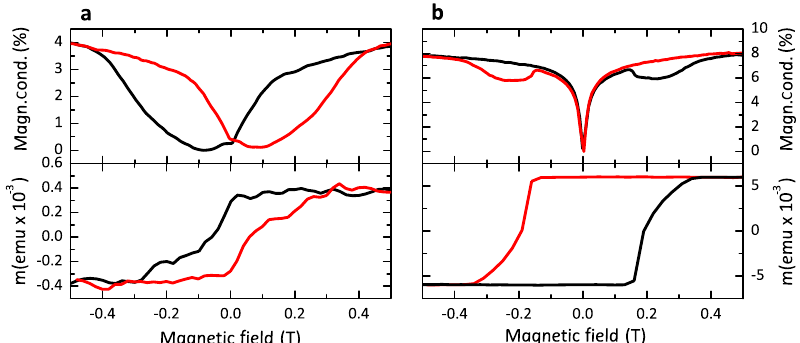
FIG. 10. Correlation between magnetoconductivity and magnetic hysteresis for different magnetic electrodes. The top panels of (a) and (b) show magnetoconductivity in completed semi–spin-valve devices; the bottom panels show VSM measurements of the magnetic electrodes before the device is completed (i.e., unpatterned bottom electrodes). The experiments were performed in a perpendicular applied magnetic field. The devices in the top panels of (a) and (b) use a 15-nm and 20-nm PEDOT spacer layer,